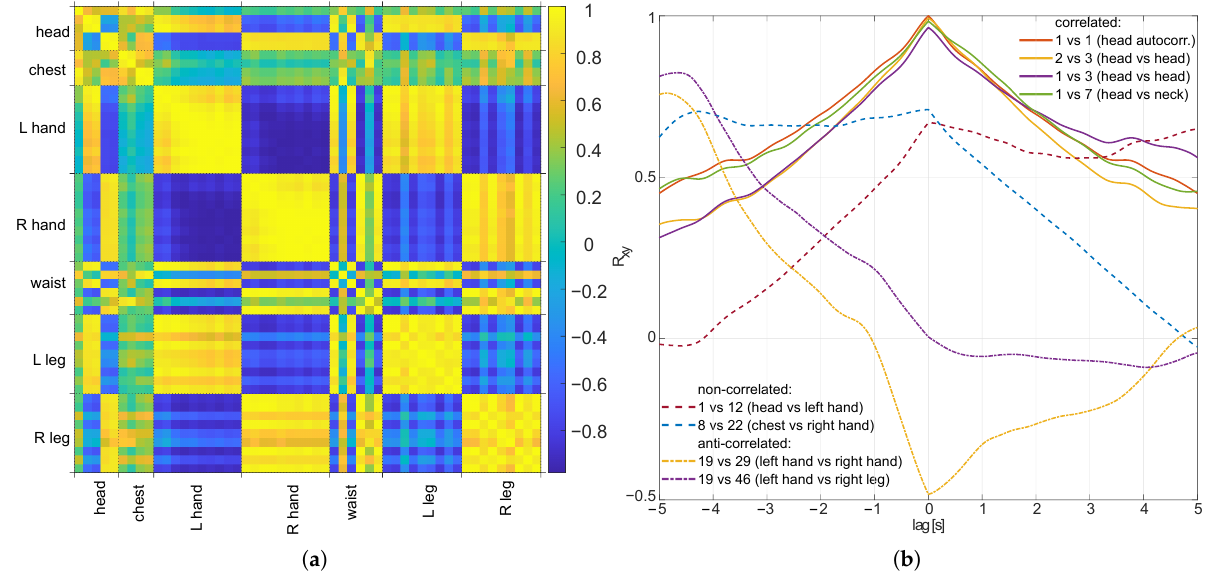
Figure 3. Correlation between X position of markers in exemplary sequence (fast walking HJ subject): ( a ) the whole sequence, all 53 markers; ( b ) inter-marker correlation function for the selected correlated and non-correlated